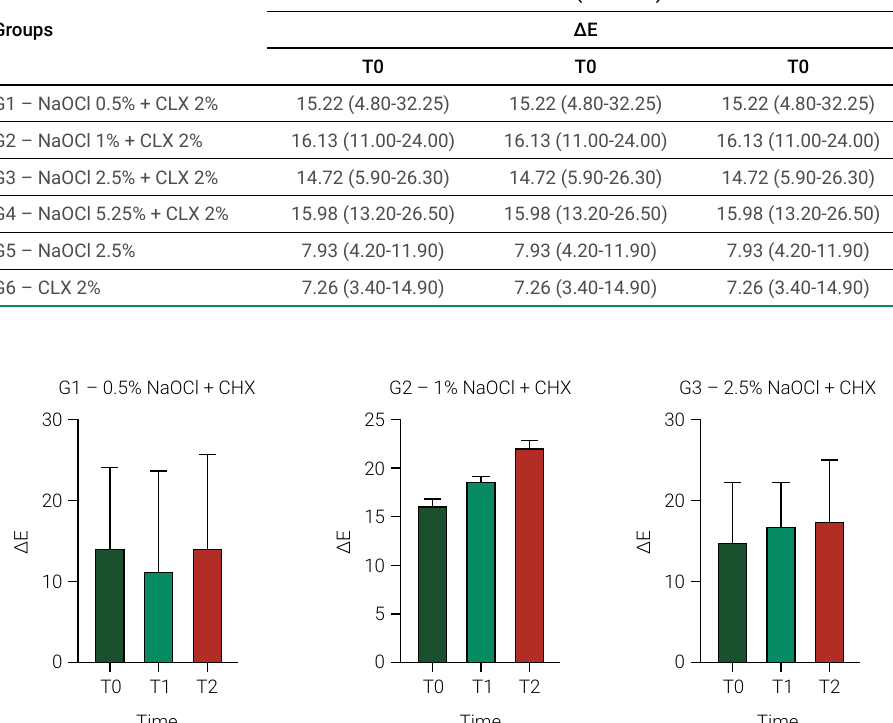
Table 1. Values for color change (ΔE) in the different groups evaluated before the irrigation protocol, immediately after and 24h after. Friedman test p <0.05. Groups